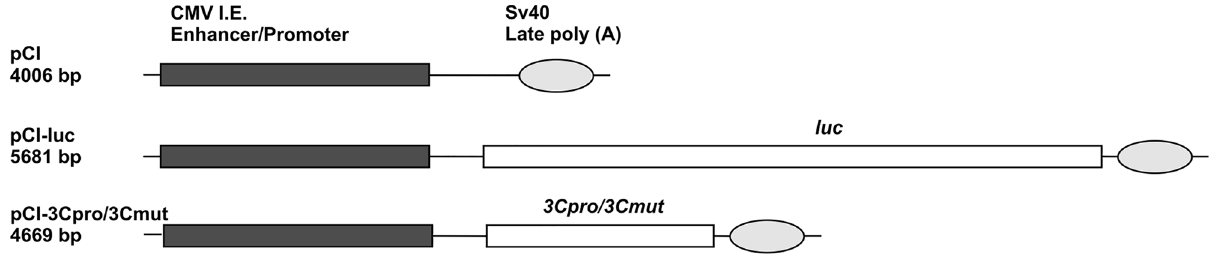
Figure 1. Structure of expression cassettes in genetic constructs used. CMV Enhancer/Promoter, enhancer and promoter of immediate early genes of human cytomegalovirus; luc , reporter luciferase gene of firefly Photinus pyrales ; 3Cpro and 3Cmut , genes of native and inactivated mutant 3C protease of human hepatitis A virus, respectively. SV40late poly(A), polyadenylation signal of SV40 late genes.